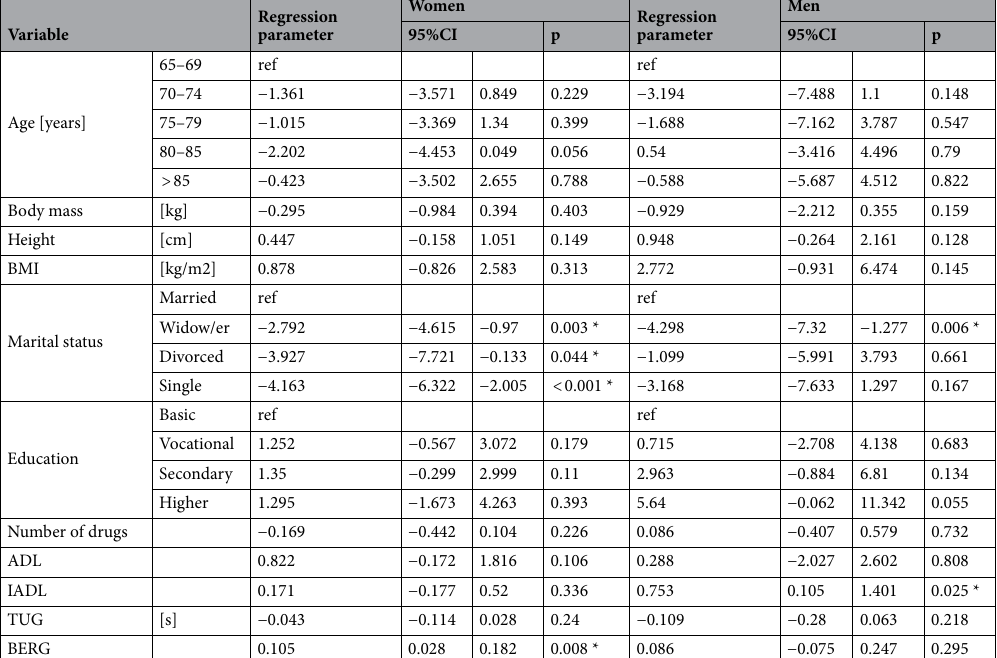
Table 4. Association between handgrip strength and other variables. BMI: body mass index, ADL: basic activities of daily living, IADL: instrumental activities of daily living, TUG: Timed up and go test, BERG: Berg Balance Test, CI: confidence interval. *Statistically significant (p <